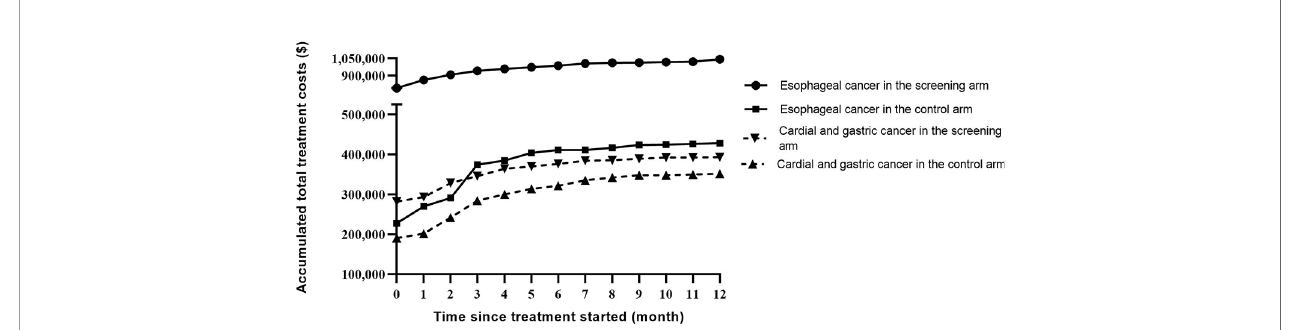
FIGURE 3 | Temporal trends of accumulated treatment costs strati fi ed by cancer type in the two